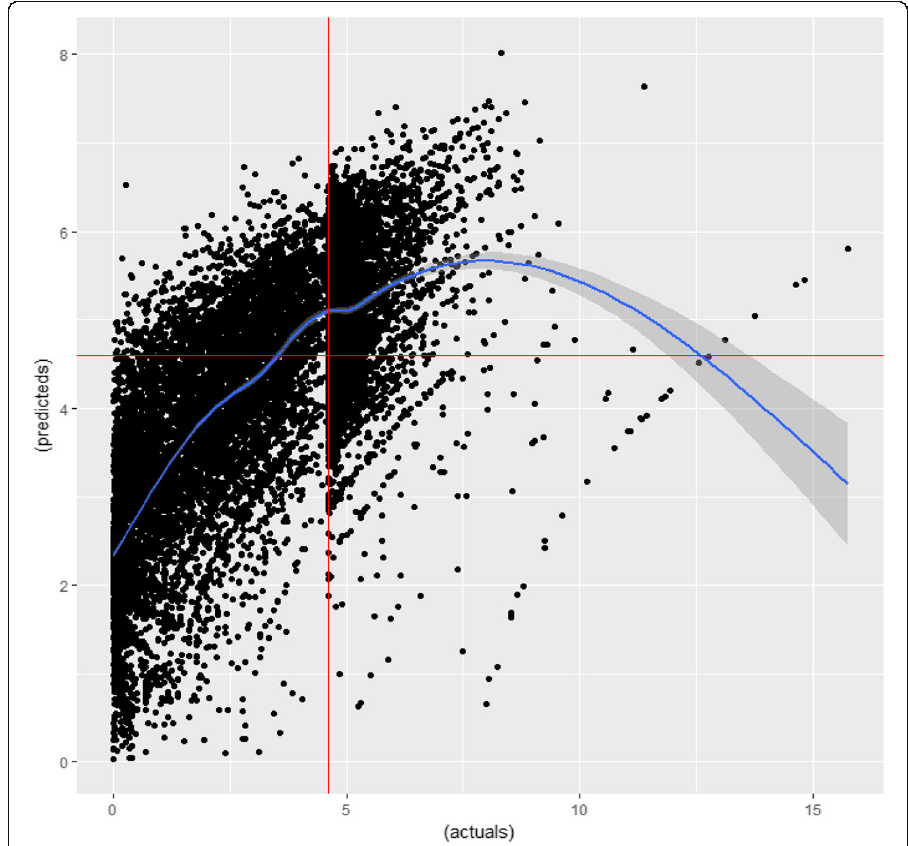
Fig. 11 Predicted scatterplot of predicted values vs actuals separated by 100% of goal